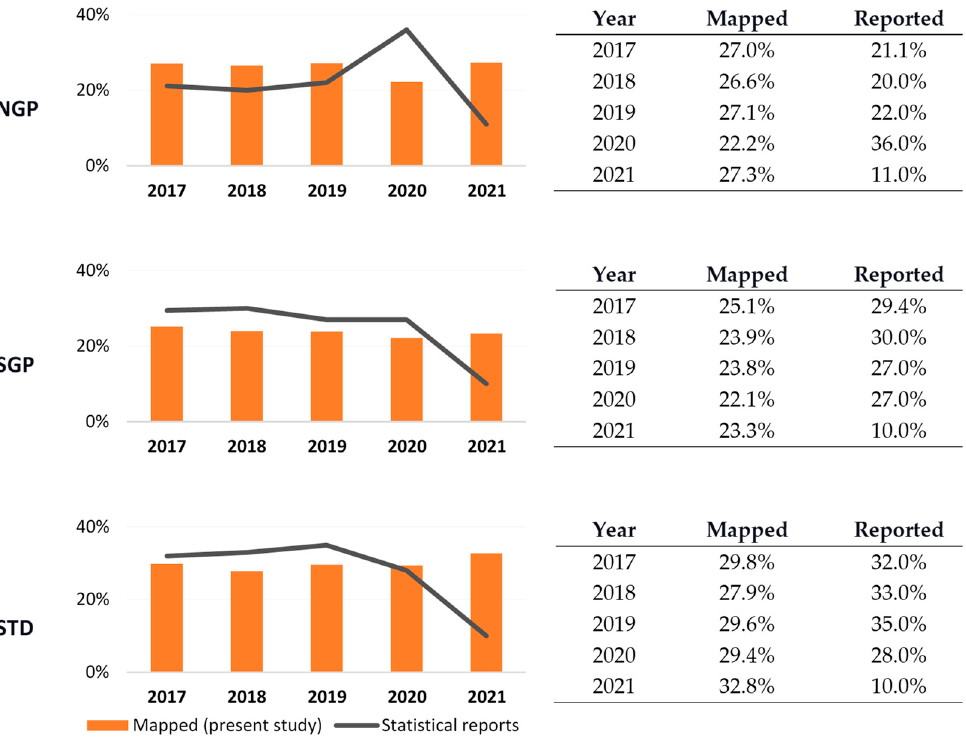
Figure 7. Yearly values for NDVI-based mapped reed area as a percentage of total pond area (orange columns). Line graphs representing data from official statistical reports are superimposed on the bar charts.